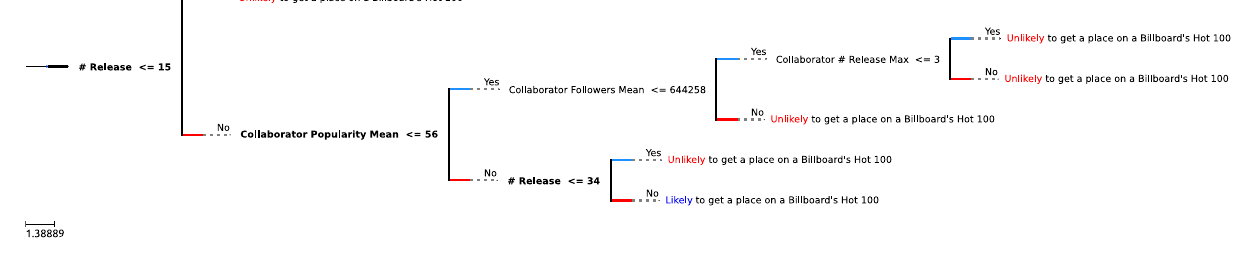
Figure 6. A visualization of XGBoost tree predicting musician’s appearance on a Billboard’s Hot 100